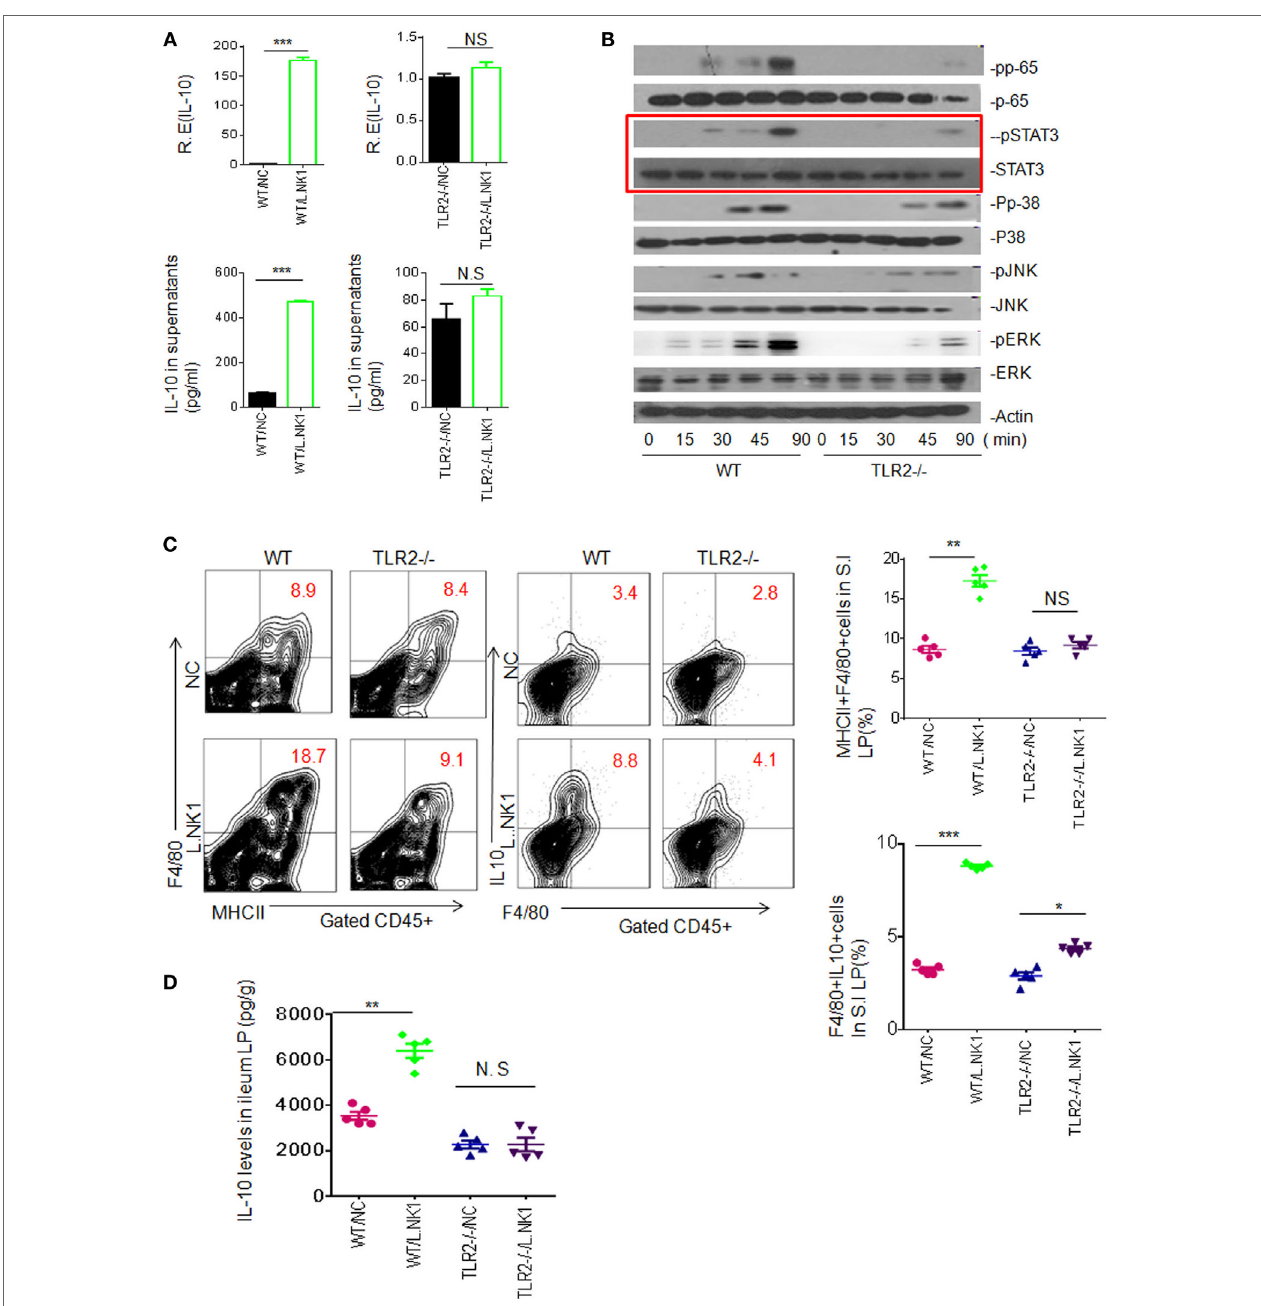
FigUre 4 | TLR2 is involved in lactobacillus NK318.1 -mediated STAT3 activation. (a) qRT-PCR and ELISA (lower) of IL-10 in the wild-type (WT) and TLR2 − / − macrophages in response to heated-dead Lactobacillus 318.1 . Macrophages were isolated from the ileum LP. (B) Immunoblotting of pp65, pSTAT3, pp-38, pJNK, and pERK in the isolated macrophages from the ileum LP of WT and TLR2 − / − mice after exposing to Lactobacillus NK318.1 . (c) Flow cytometry of MHCII( + )F4/80( + ) and F4/80( + )IL-10( + ) macrophages in the small intestinal (S.I) LP of WT and TLR2 − / − mice with (L.NK.1) or without (NC) Lactobacillus NK318.1 gavage. The proportion of MHCII( + )F4/80( + ) and F4/80( + )IL-10( + ) macrophages in WT and TLR2 − / − mice with (L.NK1) or without (NC) L.NK1 gavage were compared (right; n = 5). (D) Comparison of IL-10 in the ileum LP of WT and TLR2 − / − mice with (L.NK.1) or without L.NK.1 (NC) gavage ( n = 5). * p < 0.05, ** p < 0.01, and *** p < 0.001 [ t -test in (a) ; one-way analysis of variance in (c,D) , mean ± SD]. NS, no significant; qRT-PCR, quantitative real-time PCR; pJNK, phosphor-JNK; pERK, phosphor-ERK; WT, wild-type; LP, lamina propria.